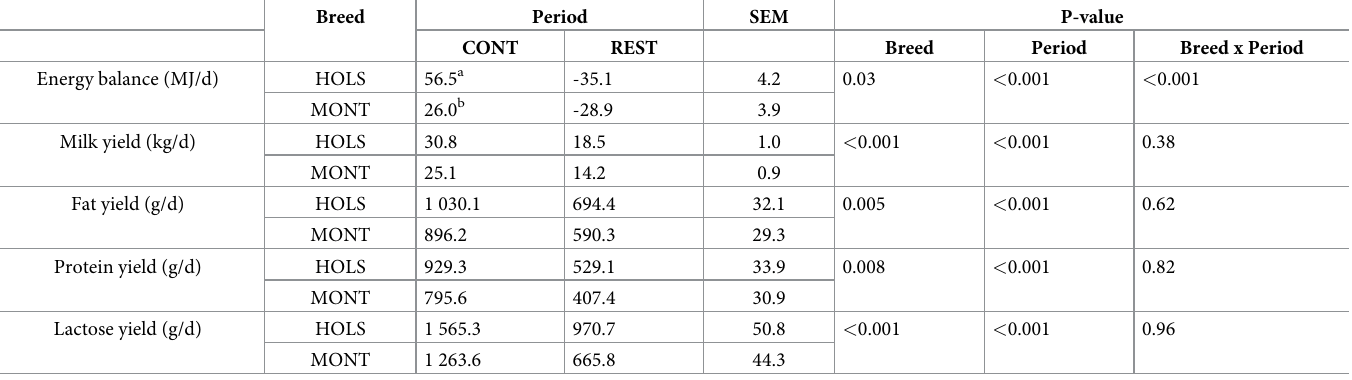
Table 1. Effects of feed restriction on energy balance, DMI, milk, milk fat and protein yields in midlactation Holstein (HOLS) and Montbe´liarde (MONT) cows dur- ing control (CONT) and restriction (REST) periods. Breed